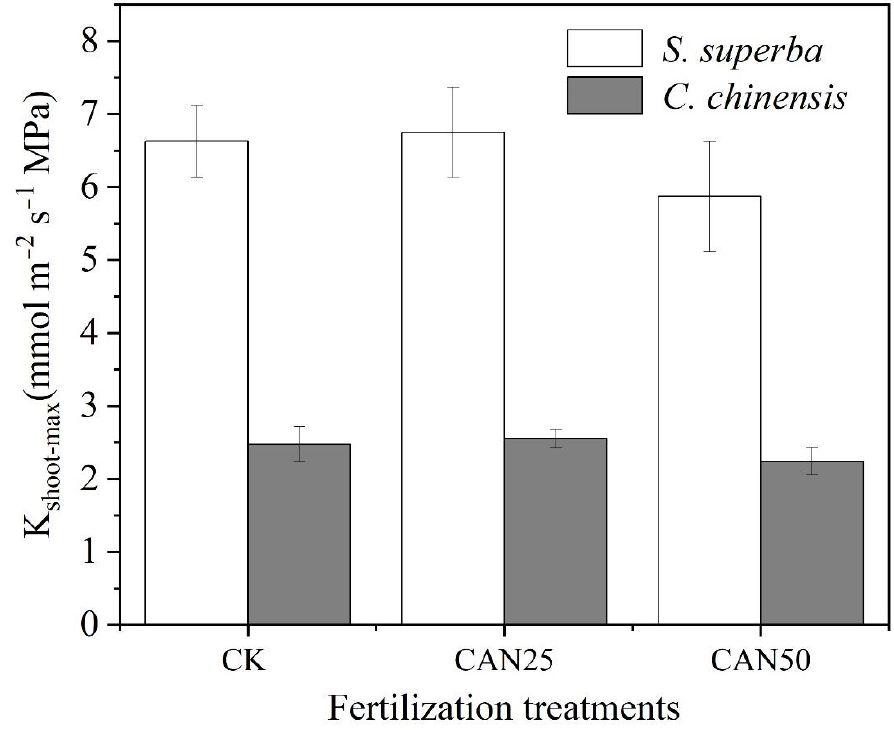
Figure 2. Comparison of the maximum shoot hydraulic conductance (K shoot-max ) among different fertilization treatments .